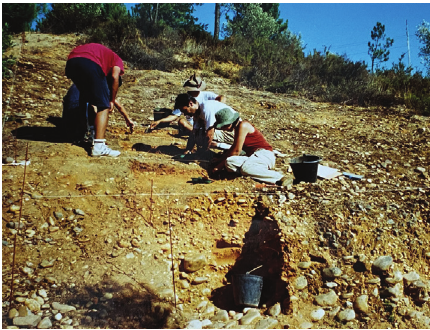
Figure 2 Tobias Stone excavating in Portugal, 1990s (Source: Tobias